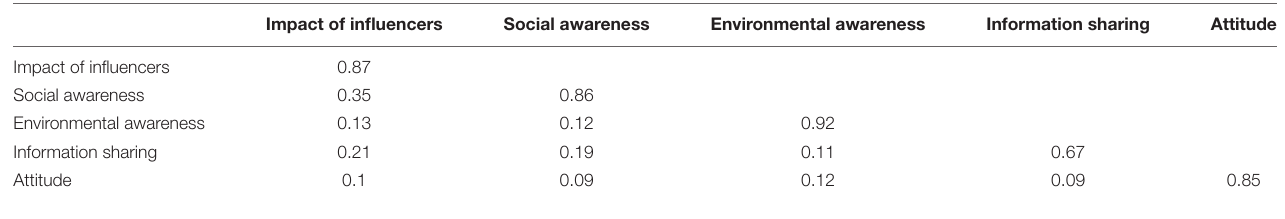
TABLE 5 | Results of discriminant validity